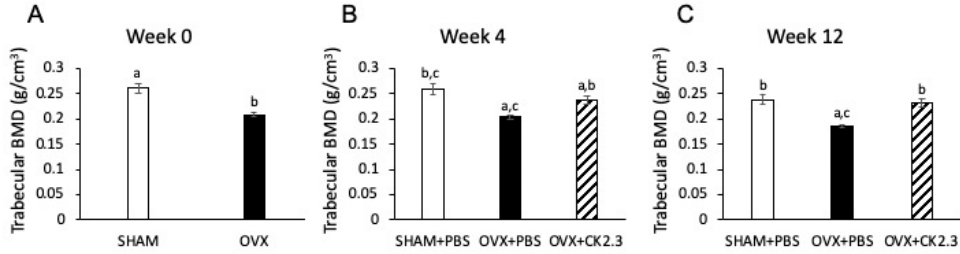
Figure 2. CK2.3 increased trabecular BMD femoral head of OVX rats. ( A ) OVX rats had lower baseline (week 0) BMD than SHAM rats; ( B , C ) Treatment with CK2.3 show a significant improvement in BMD in the femur of OVX rats in week 4 ( B) and week 12 ( C) . (a) indicated a significant di ff erence over SHAM, (b) indicated a significant di ff erence over OVX or OVX + PBS, (c) indicated a significant di ff erence over OVX + CK2.3.